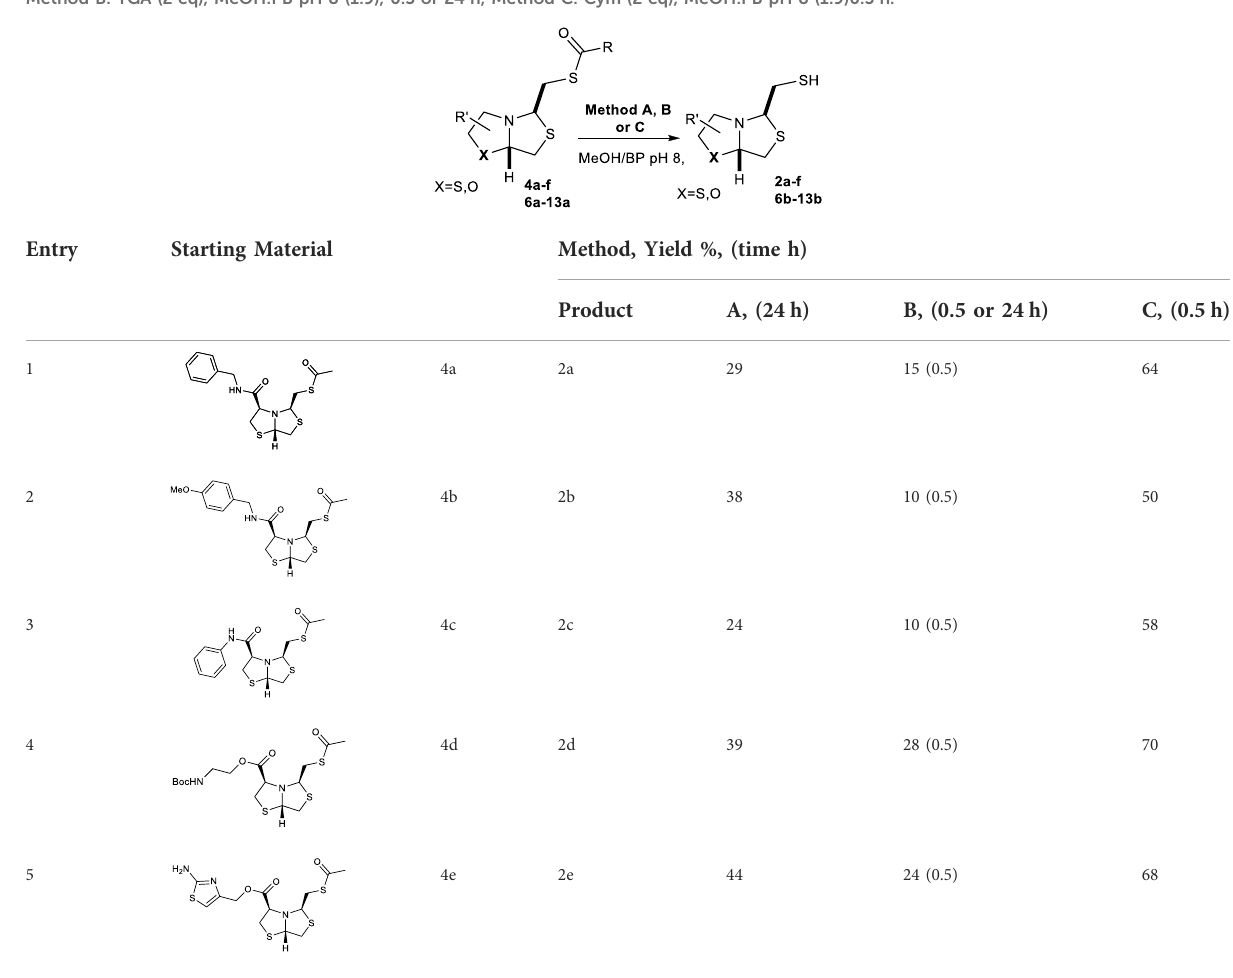
TABLE 3 Thiol deprotection yield (%) using Method A, B and C of different substituted BTZ. Method A: TG-NCO-SH (2 eq) MeOH:BP pH 8 (1:9), 24 h; Method B: TGA (2 eq), MeOH:PB pH 8 (1:9), 0.5 or 24 h; Method C: Cym (2 eq), MeOH:PB pH 8 (1:9)0.5